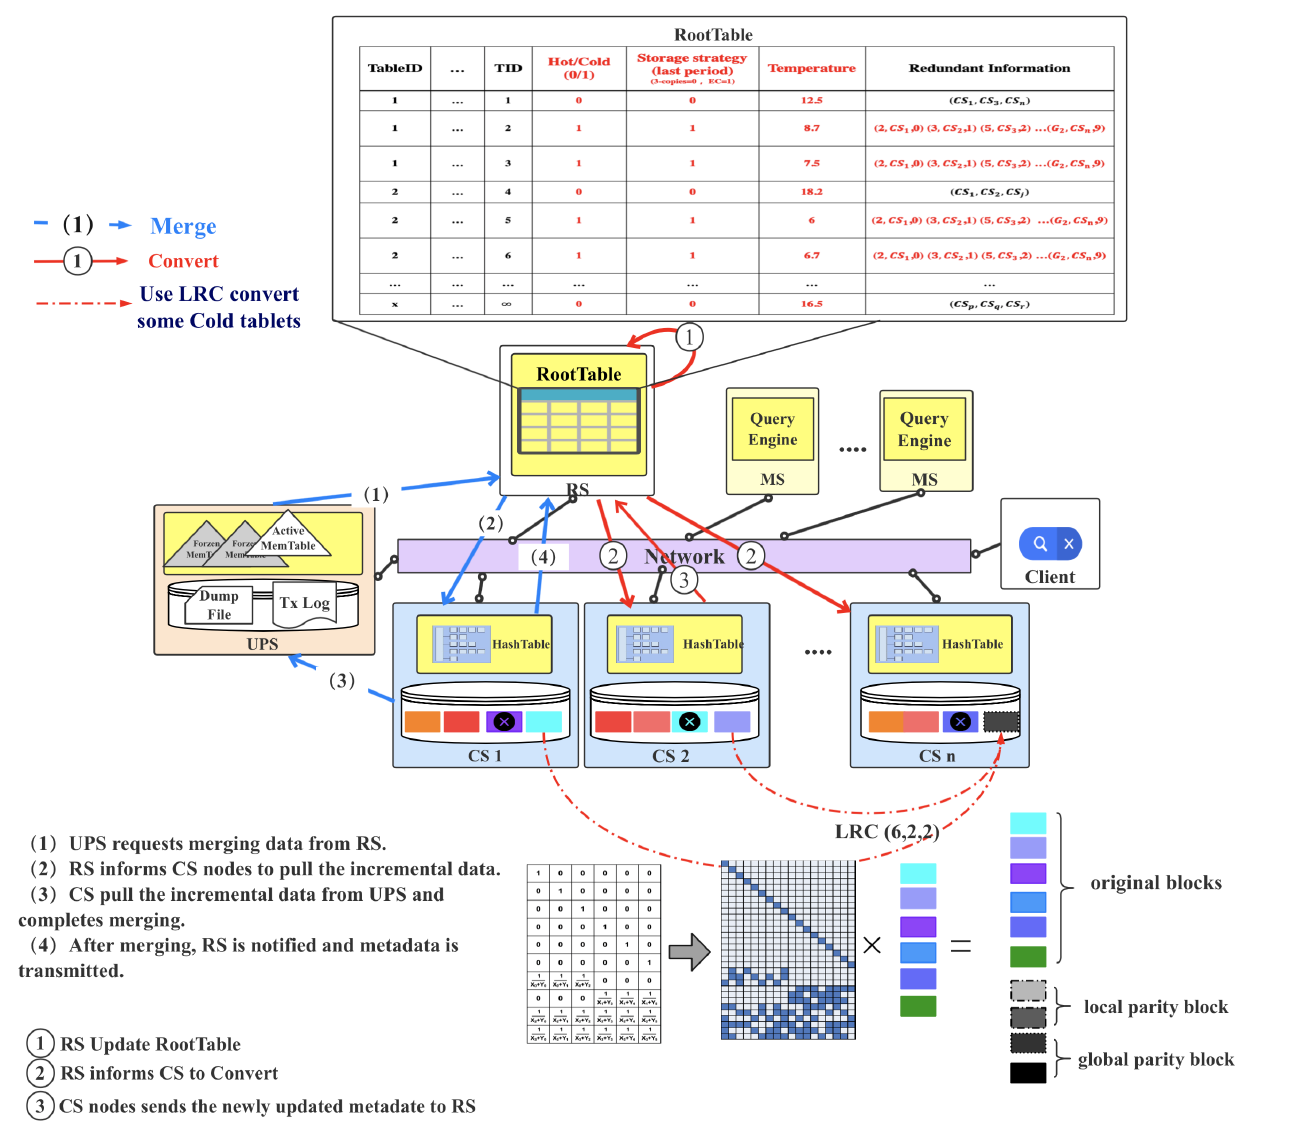
Figure 3. Merge and convert operations based on CBase-EC strategy on CBase. The blue line represents the process of daily merges. The red line indicates the dynamic conversion process of hot and cold tablets storage after completed merging. The RootTable shows the added column information in red color. The bitmatrix representation of locally repairable code (6,2,2) in the lower right corner of this